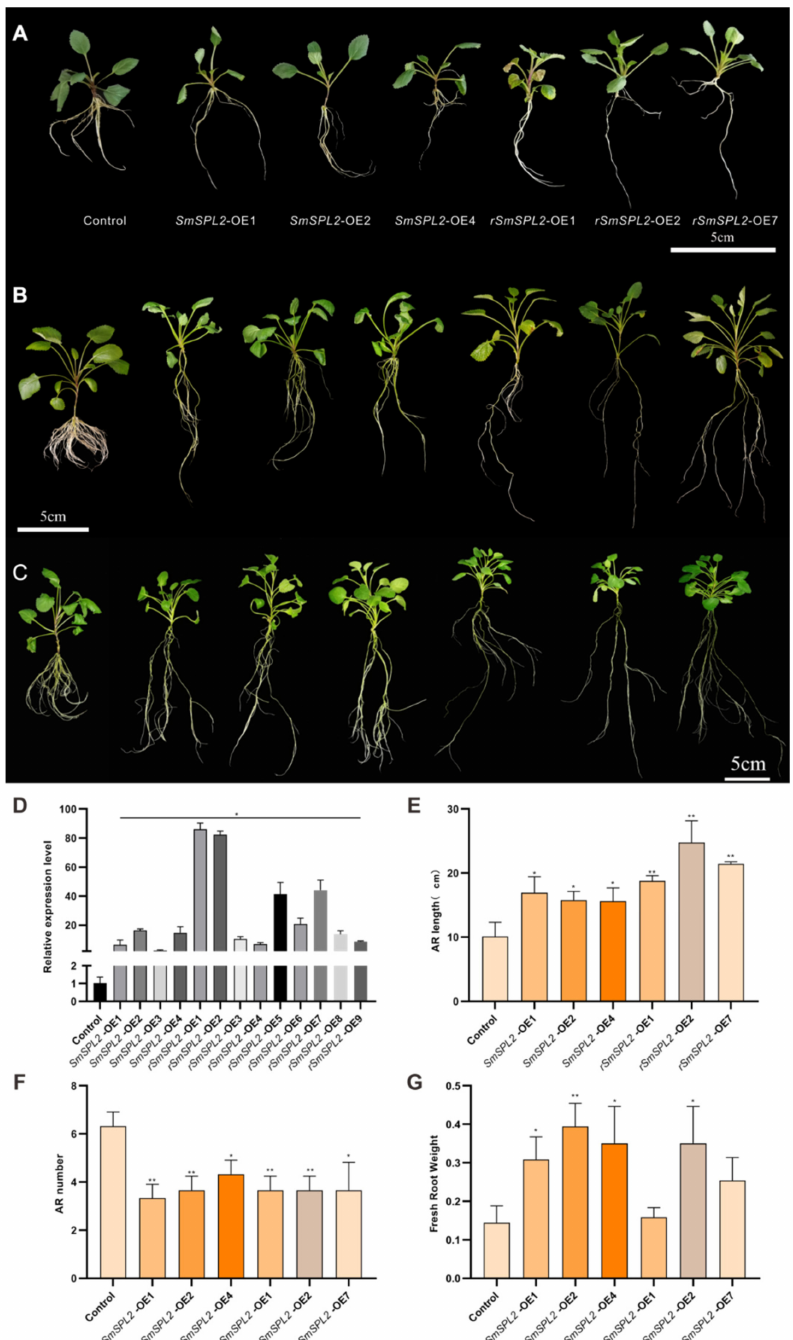
Figure 3. Phenotype of transgenic S. miltiorrhiza plantlets overexpressing SmSPL2 (SmSPL2-OE) and miR156-resistant SmSPL2 (rSmSPL2-OE). ( A – C ) Phenotype of 15-day-old ( A ), one-month-old ( B ), and two-month-old ( C ) transgenic S. miltiorrhiza plants. ( D ) Expression levels of SmSPL2 in the roots of different transgenic lines. ( E – G ) Adventitious root (AR) length ( E ), AR numbers ( F ), fresh weight of root ( G ) of two-month-old transgenic lines. All data are mean values of three biological replicates, with the error bar representing SD. * and ** indicate significant differences from the control at p < 0.05 and p < 0.01 level, respectively, by Student’s t